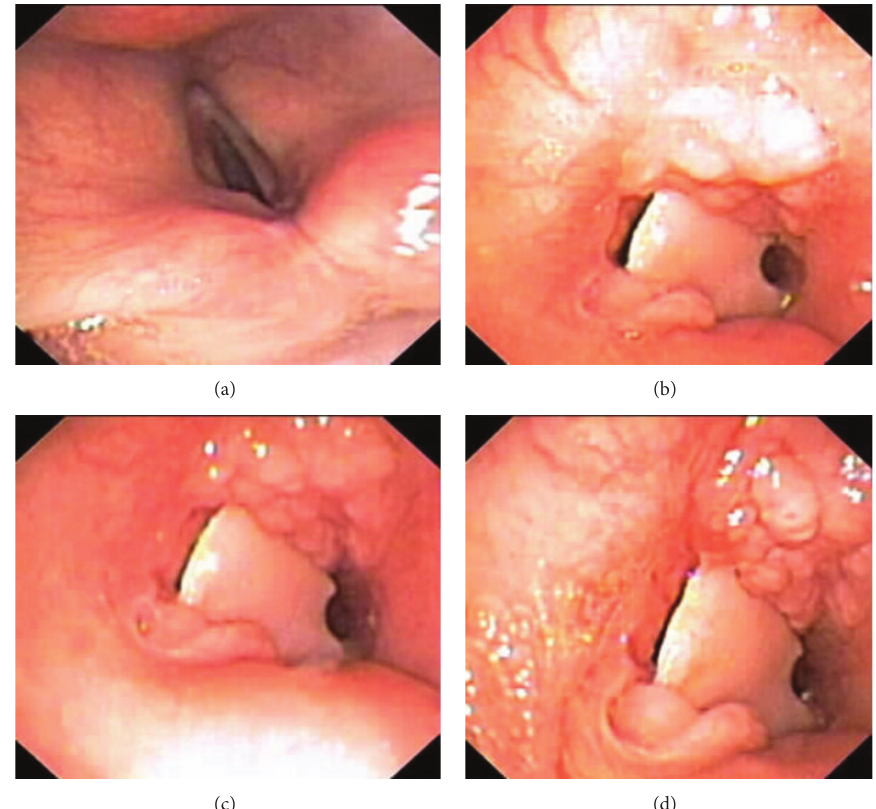
Figure 3: Bronchoscopic images showing vocal cords (a) and different views of the foreign